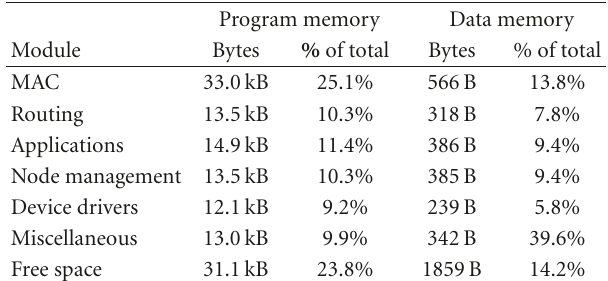
Table 4: TUTWSN protocol stack resource utilization. Table 5: Measured duty cycle of MCU and radio.